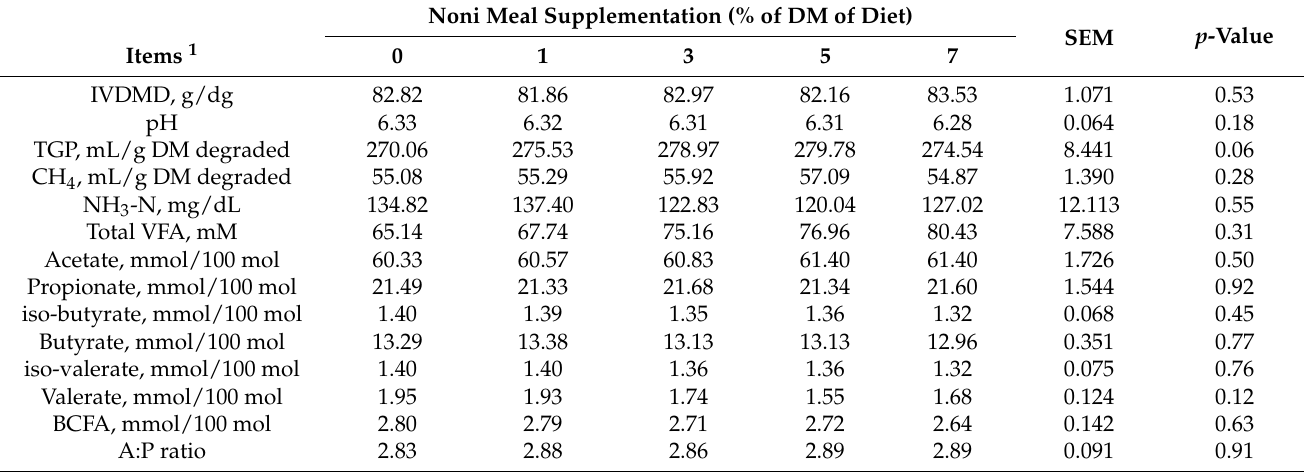
Table 5. Effect of noni meal on rumen in vitro dry matter digestibility (IVDMD), pH, total gas produc- tion (TGP), CH 4 , and NH 3 -N production, and volatile fatty acids (VFAs) profiles in 48 h